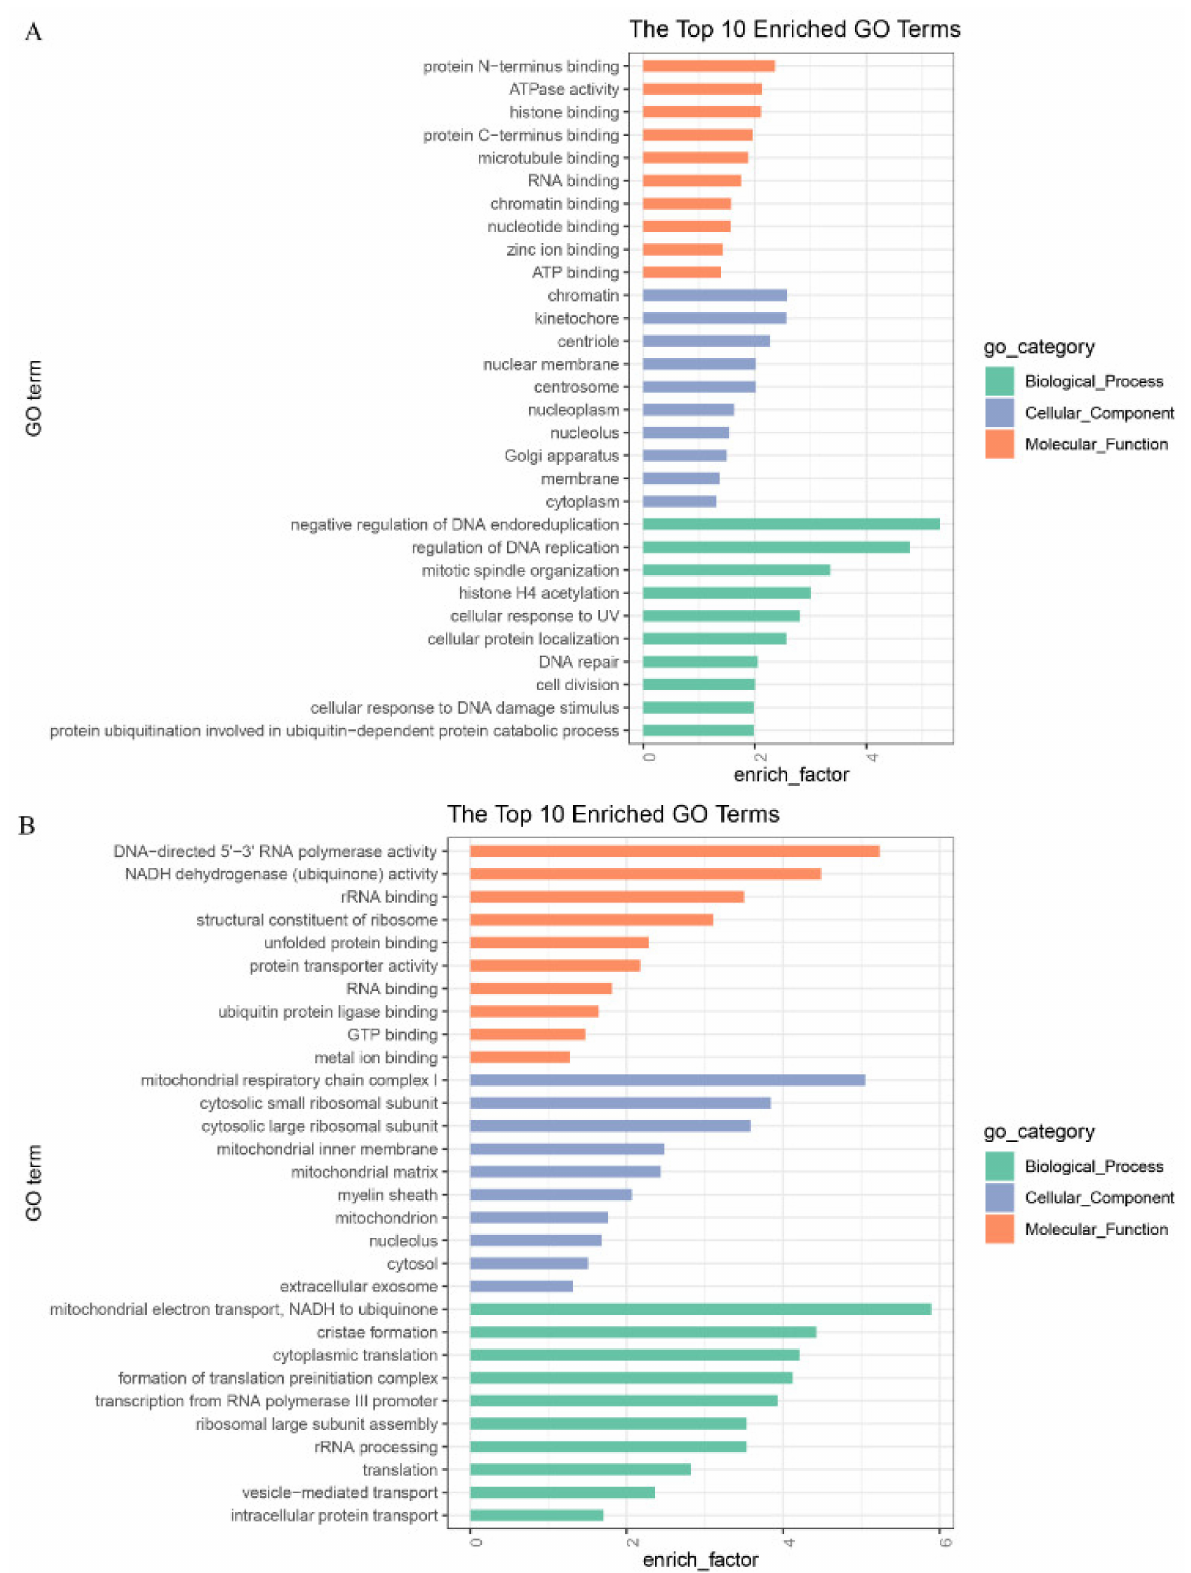
Figure 3. GO enrichment of ( A ) up-regulated DEGs and ( B ) down-regulated DEGs with the top 10 terms in biological process, cellular component, and molecular